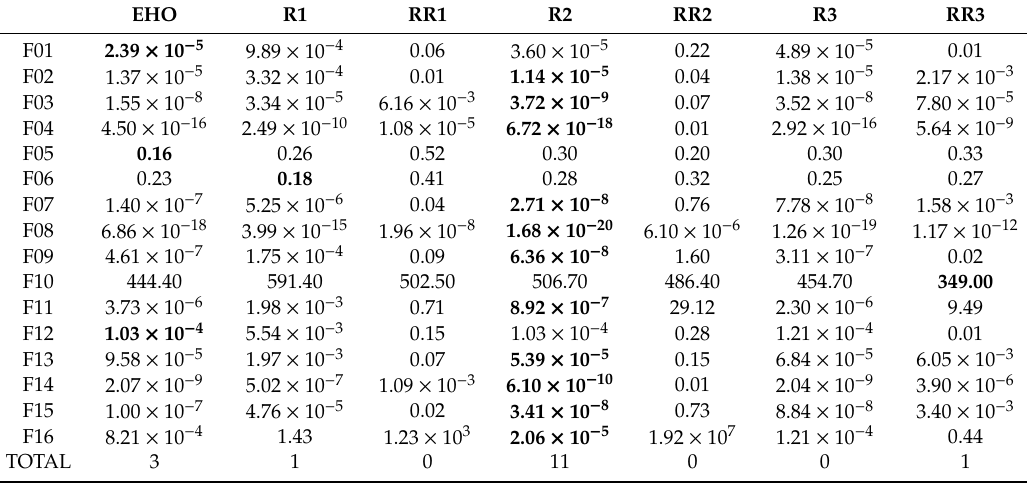
Table 3. Standard values obtained by EHO and six improved methods with D =